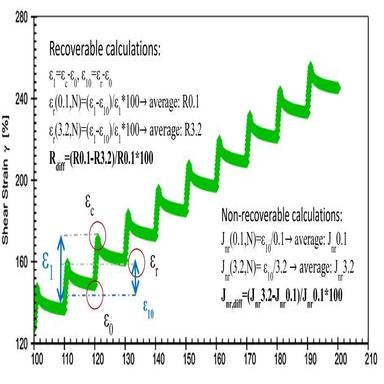
Strain response under MSCR test and related formulas.